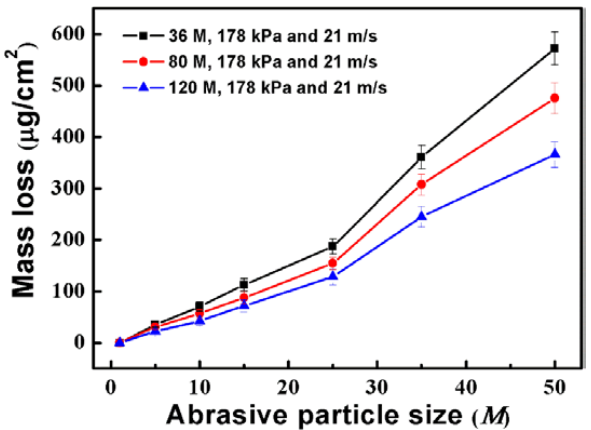
Figure 8. Average mass loss of the specimens after immersion for 1, 5, 10, 15, 25, 35, and 50 days.